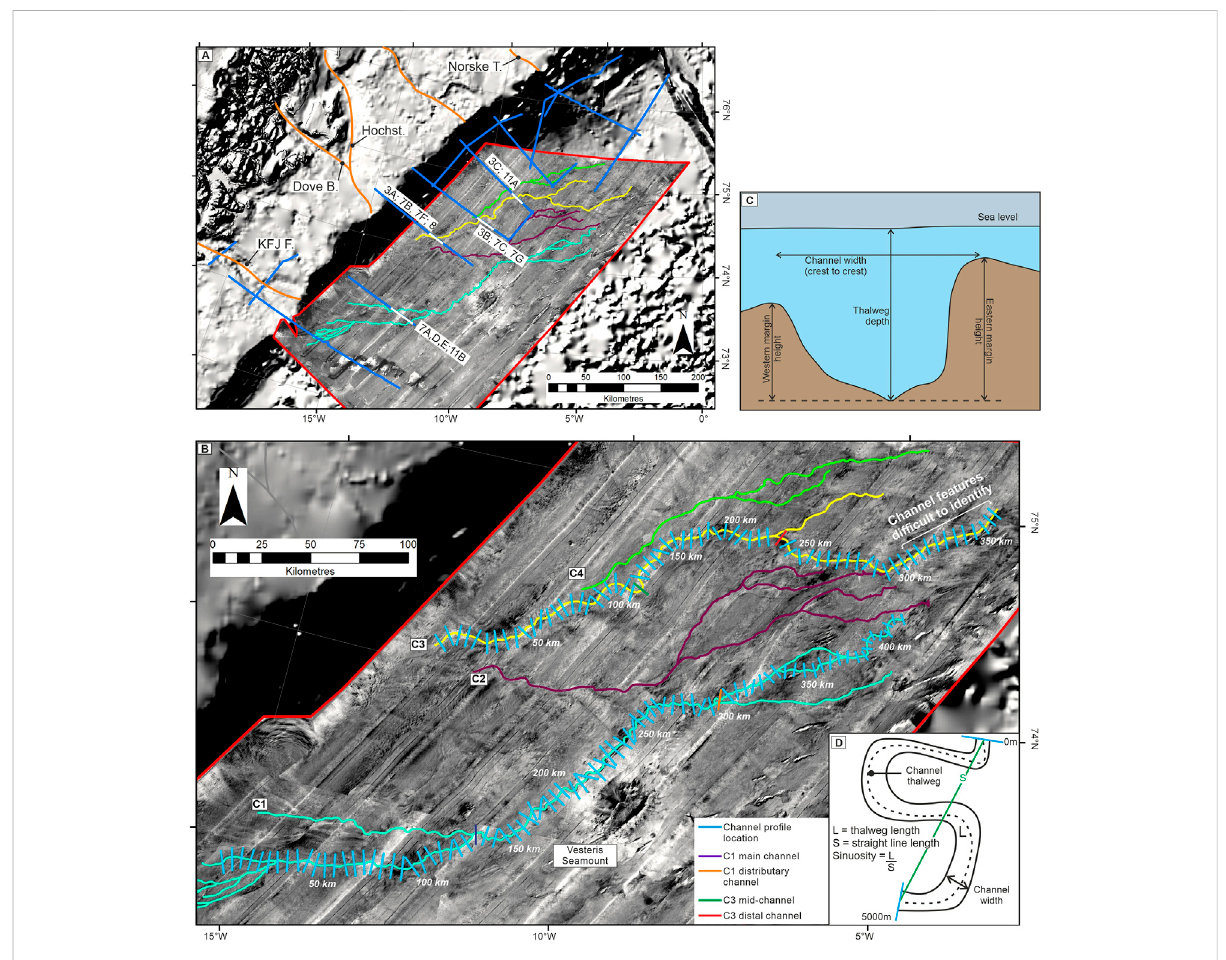
FIGURE 2 (A) IBCAO bathymetric dataset, and GLORIA dataset (outlined in red) used in morphometric analysis. 2D seismic survey delineated in blue, with corresponding fi gure numbers. Channel systems studied shown in cyan, magenta, yellow and green. Orange lines mark the trend of former glacial troughs in García et al. (2012); Norske T.: Norske Trough; Hochst: Hochstetterbugten; Dove B: Dove Bugt; KFJ F.: Kejser Franz Josef Fjord. (B) Location of pro fi les used to parameterise channel shown in cyan, with the transition from C1 feeder channel to C1 main channel delineated in purple,andC1mainchanneltodistributarychanneldelineatedinorange.C3proximaltomid-channeldelineatedingreen,andmid-channeltodistal channel delineated in red. (C) Parameter calculations for cross-sectional channel analysis. (D) Parameters for planform channel